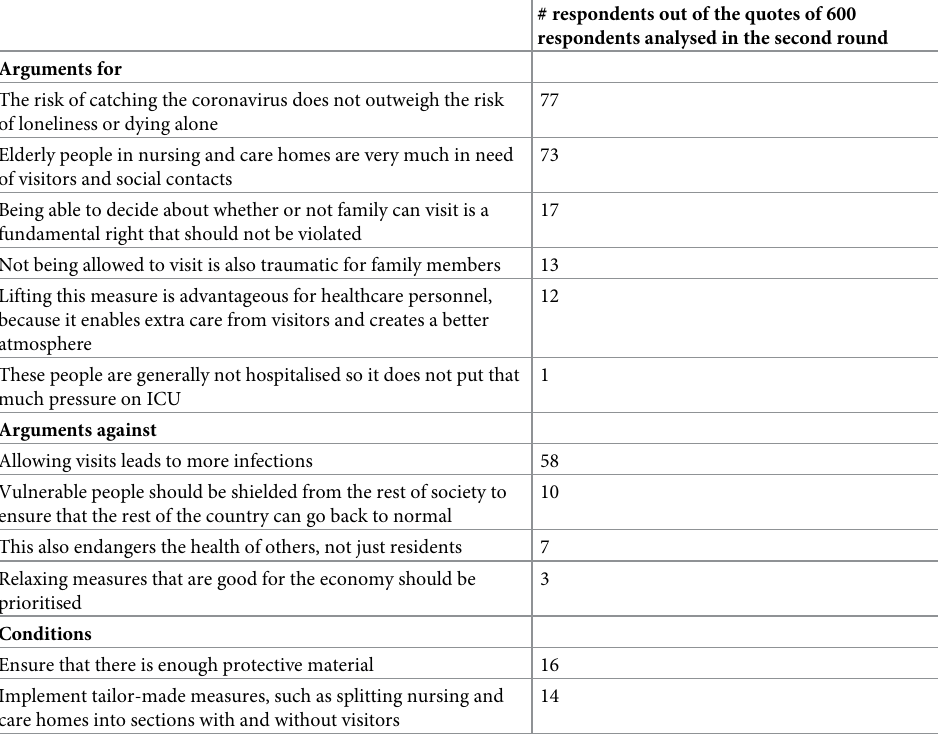
# respondents out of the quotes of 600 respondents analysed in the second round